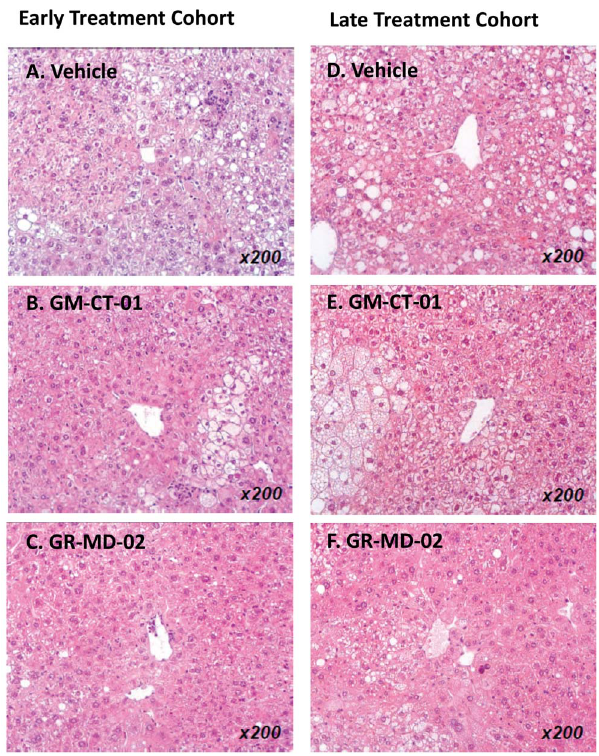
Figure 1. Liver histology stained with H&E. Early and late treatment cohorts were administered intravenously twice weekly vehicle (0.9% NaCl), GM-CT-01 (120 mg/kg), or GR-MD-02 (60 mg/kg). Images are representative of each group of animals as selected by the examining pathologist.